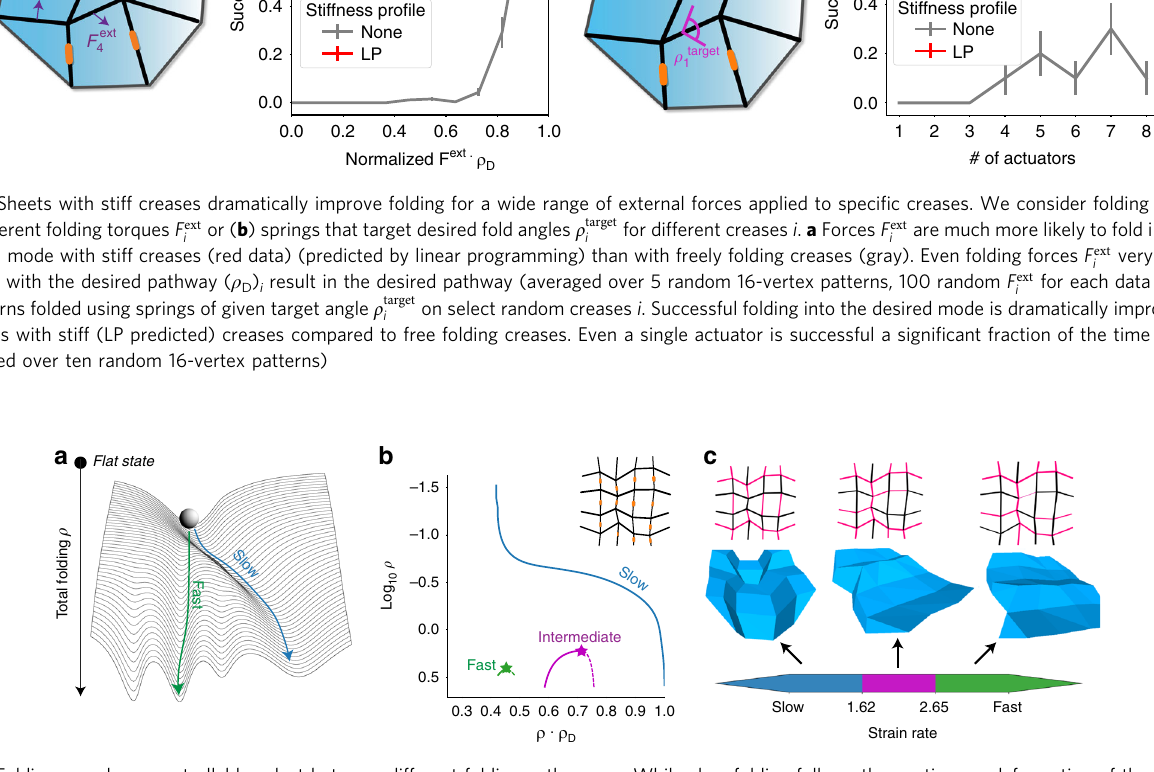
Fig. 5 Folding speed can controllably select between different folding pathways. a While slow folding follows the continuous deformation of the unique mode at low strain ρ (blue), fast folding results in a state that most “ resembles ” that low- ρ mode (green). If the unique low- ρ mode is signi fi cantly distorted in geometry relative to the slow folding target, slow and fast folding can result in very different outcomes. b , c We systematically attempted folding at different strain rates (relative to a fi xed hinge relaxation timescale) for the 16-vertex pattern with stiff creases shown. We fi nd three distinct outcomes at slow, intermediate, fast rates that completely differ in their Mountain-valley states, geometry and energy. The slow folding outcome corresponds to following the blue path in (b) while the intermediate and fast pathways cross over from blue to the magenta and green modes, respectively, at some intermediate folding